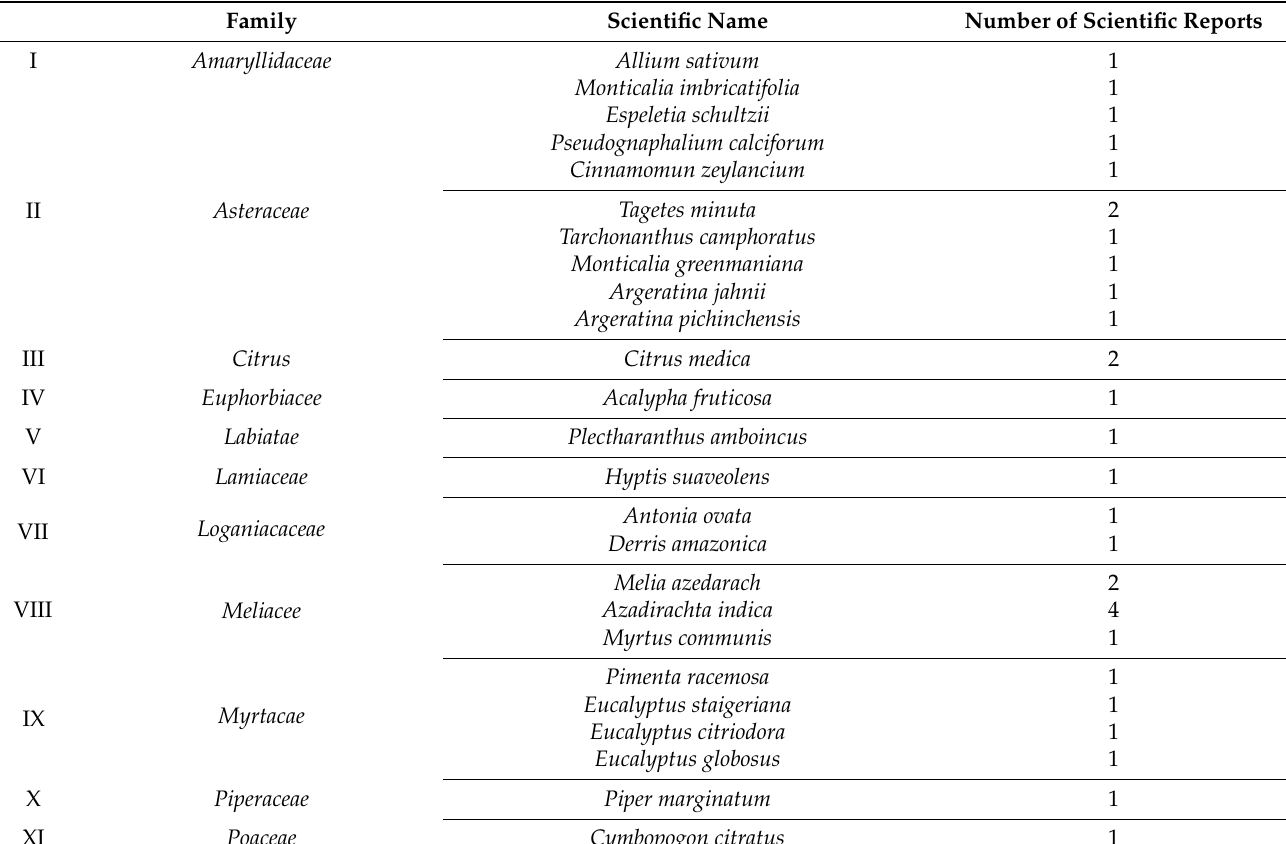
Table 2. Botanical products tested as insecticide and/or repellent in the studies